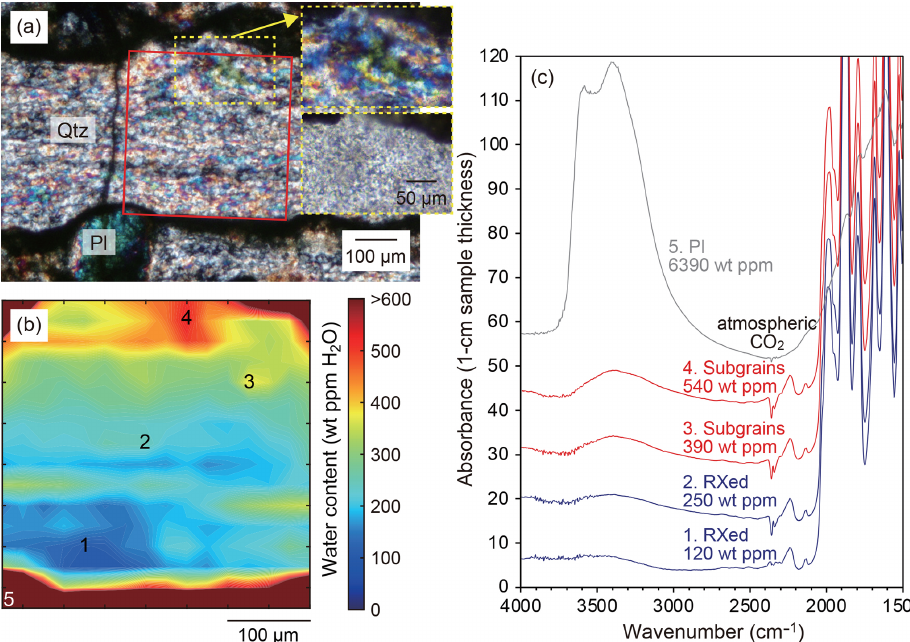
Figure 9. IR mapping results for the strongly deformed sample. The sample thickness is 112µm. (a) Optical photomicrograph under cross- polarized light. The IR mapped area is shown with a red square. The two insets in the yellow rectangles show enlarged images of a region that includes a relic of a host grain at the center under cross-polarized (upper) and plane-polarized (lower) light. (b) Water distribution. Numbers represent raw IR spectra in (c) . Color-coded water contents up to 600wtppm H 2 O are for quartz, and those above are for plagioclase and phyllosilicate around no. 5 and others in (b) . Quartz subgrains in host grains are around nos. 3 and 4 in (b) , which correspond to the microstructure in (a) . “RXed” in (c) means